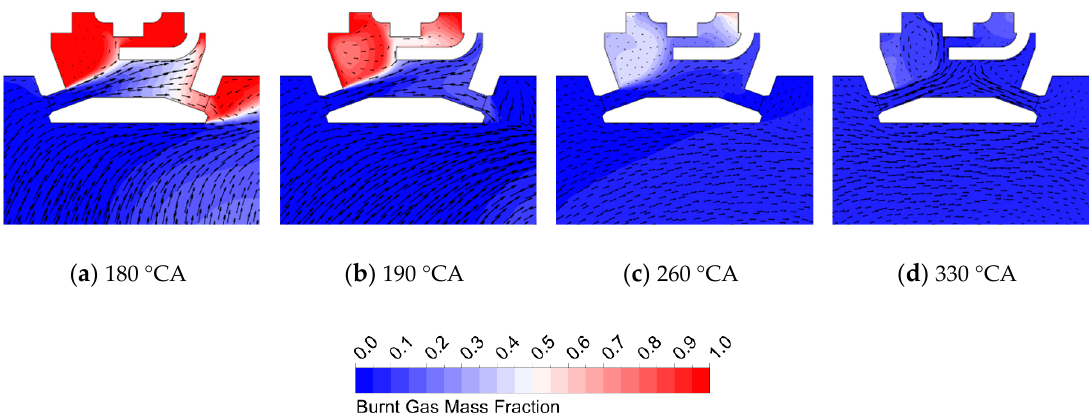
Figure 8. Scavenging behavior at 7500 rpm and full load inside the PN8 prechamber.